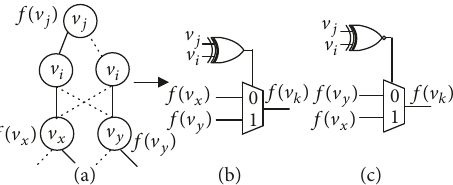
Figure 5: The case in Theorem 5: (a) BDD subgraph, (b) XOR, and (c)